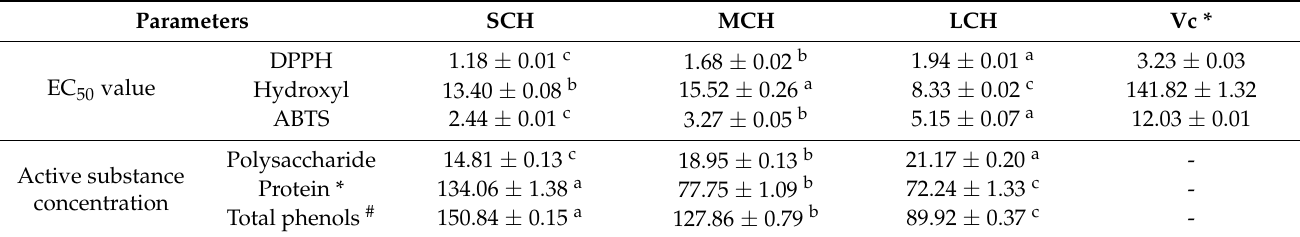
Table 6. Antioxidant activities and main active substances of coconut haustorium extract 1 .